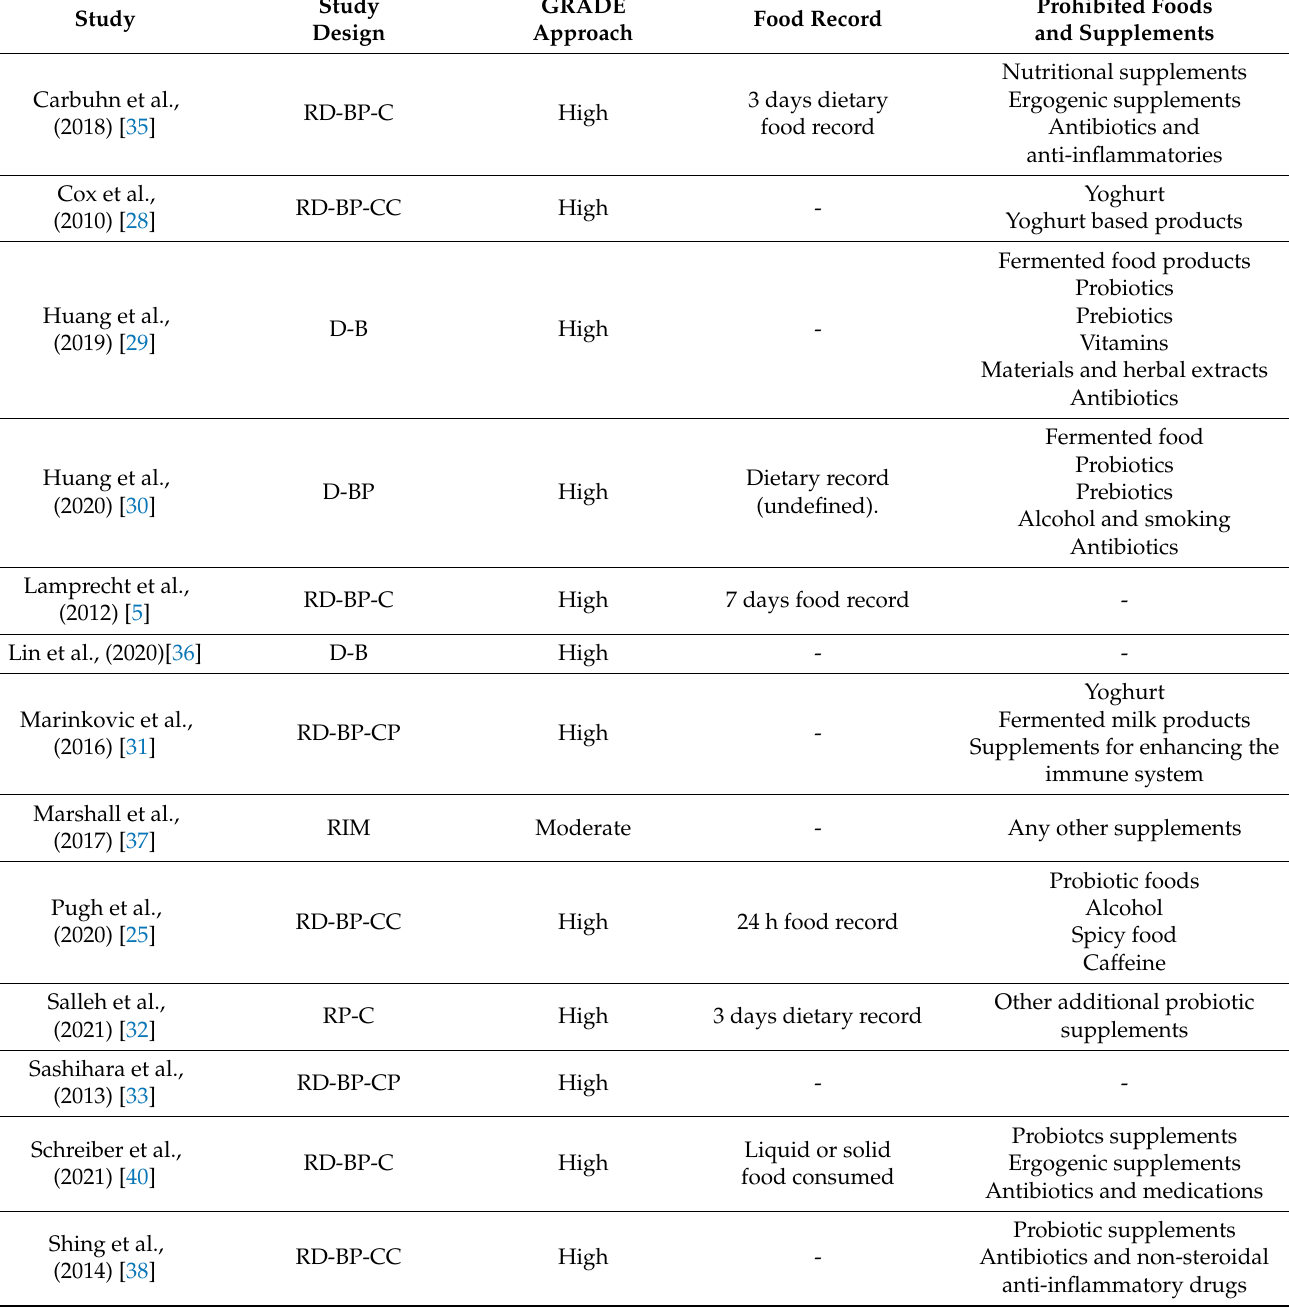
Table 5. Information about study design and nutritional control in included